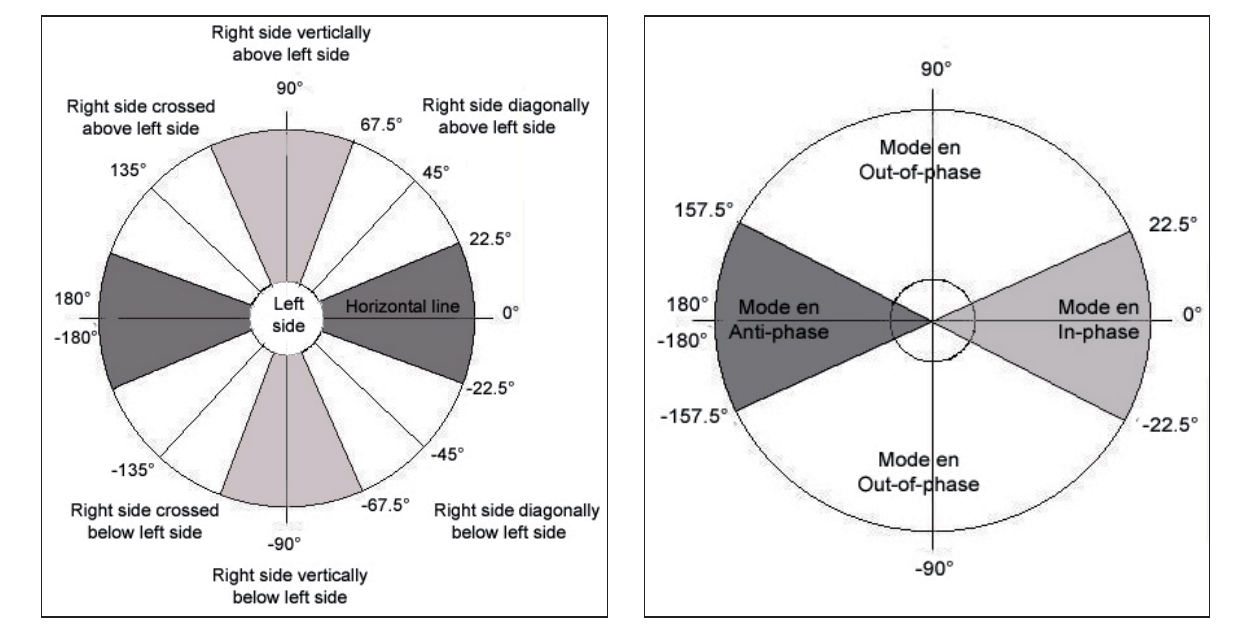
Figure 2. Angle between horizontal position, the left limb and the right limb